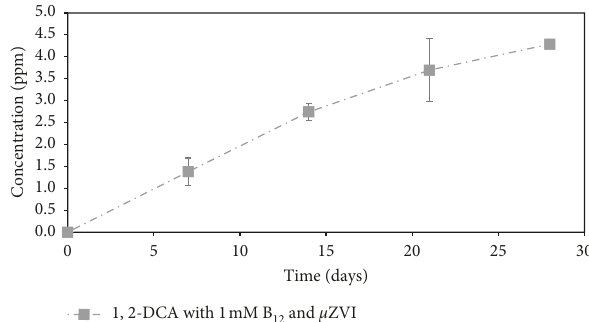
Figure 6: Increase of free chloride in solution of 1,2-DCA (13.52 mg/l) in the presence of 1mM · B 12 and 0.5 g of µ ZVI.